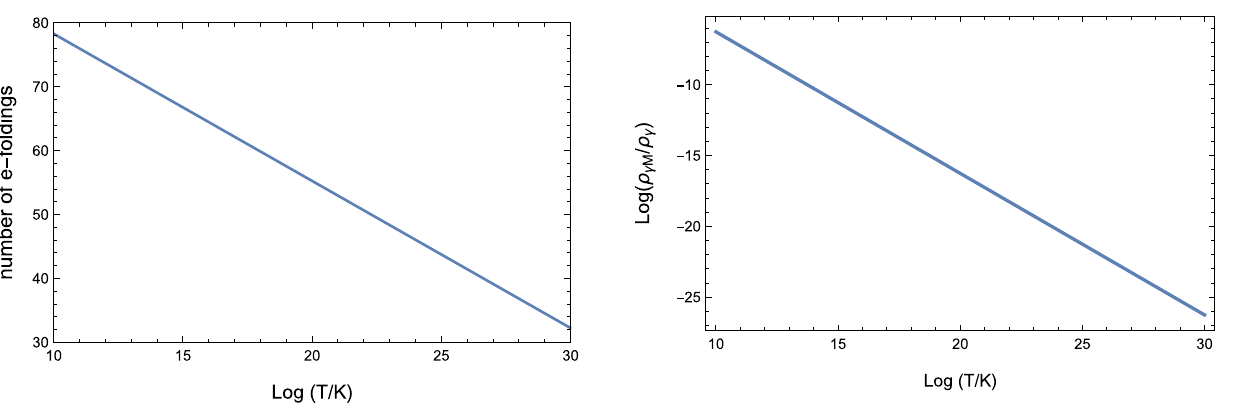
Fig. 3 Decimal Log of the ratio of the energy density of the photons radiated from monopolium to the conventional blackbody photon radi- ation as a function on the decimal Log of the reheating temperature in Kelvin de-excitation ρ γ M ( T ) = Mn ( T ) given